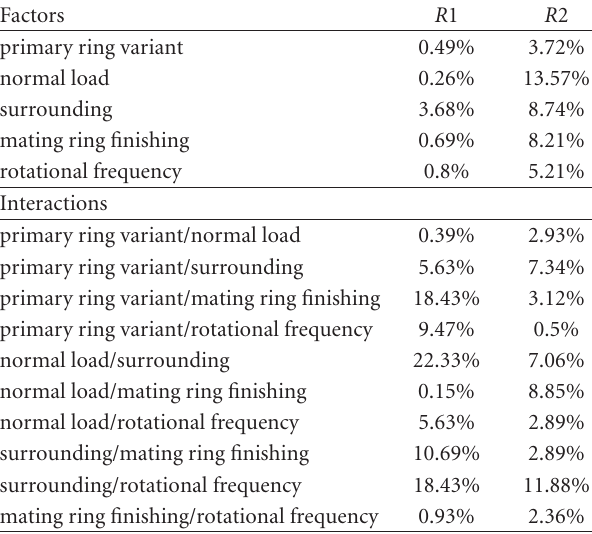
Table 3: Percentage of contribution of every factor and interaction on the coe ffi cient of dynamic friction ( R 1) and on the wear ( R 2) after 10 hours of friction